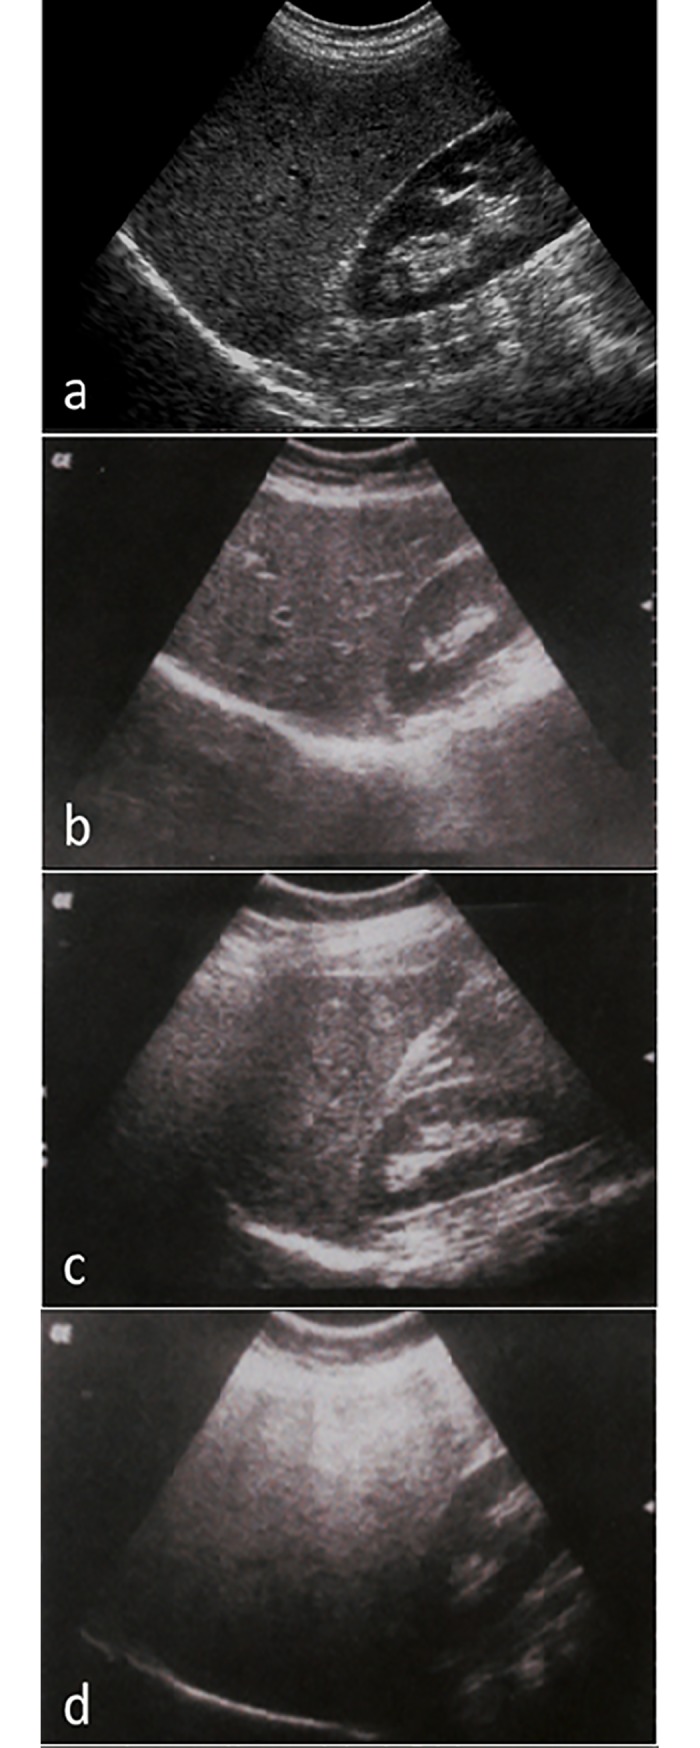
Gradation of hepatic steatosis: a. Normal liver echotexture. Longitudinal section through the right lobe of the liver. Similar echogenicity between liver parenchyma and the cortex of the right kidney. Intra-hepatic vascular anatomy is clearly visible and posterior aspects of the liver are well depicted; b. Mild—slightly increased echogenicity when compared to the renal cortex; blood vessels/diaphragm in view; c. Moderate—clear increased echogenicity of the liver parenchyma, impaired visualisation of intrahepatic vascular anatomy, decreased echogenicity of the renal cortex; d. Severe—marked increased echogenicity/absorption, poor penetration and visualisation of intrahepatic vascular anatomy and diaphragm, marked decreased echogenicity of the renal cortex.